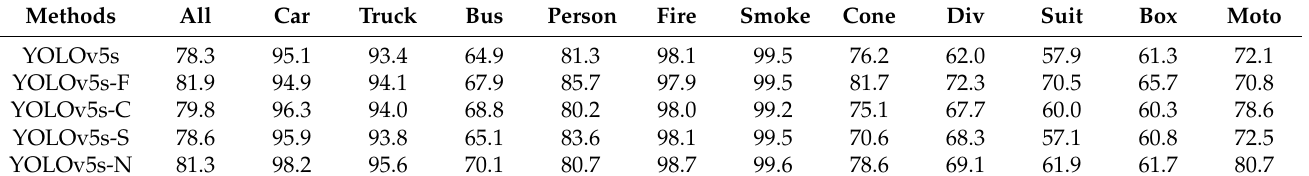
Table 1. Comparison of multi-scale YOLOv5s models’ performances for each category, results in mAP@0.5.